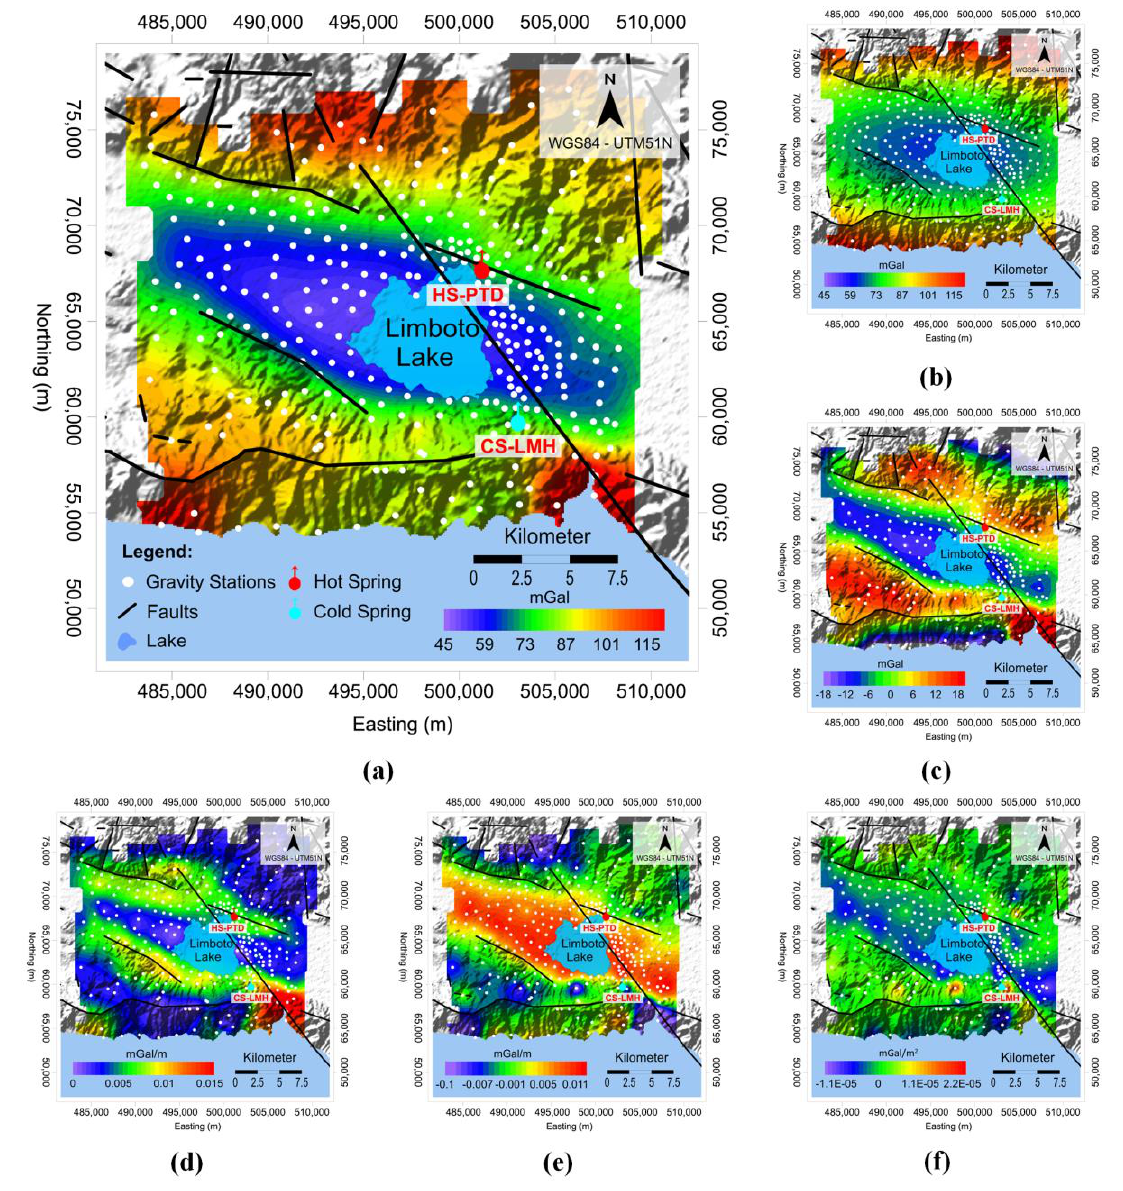
Figure 10. ( a ) Complete Bouguer anomaly (CBA) map from gravity result at Lake Limboto — Pentadio area with an assumed Bouguer density correction of 2.5 g/cm 3 ; ( b ) regional and ( c ) residual anomaly maps from Bouguer anomaly separation; and ( d ) HD, ( e ) VD, and ( f ) SVD values of the Bouguer anomaly.